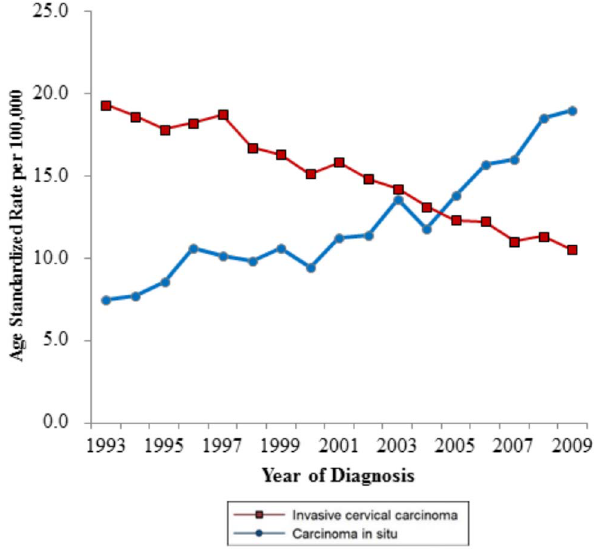
Figure 1. Treads in age standardized in situ and invasive cervical carcinoma rates and Ratio of age-standardized invasive to insitu cervical carcinoma rates, Korea, 1993–2009.